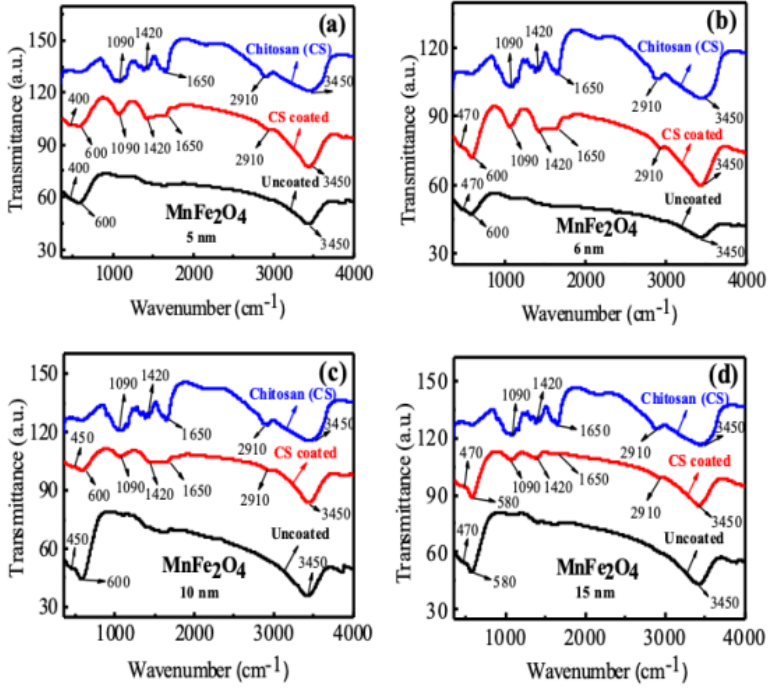
Figure 8. FTIR spectra of uncoated MnFe 2 O 4 , CS-coated MnFe 2 O 4 , and CS nanoparticles for sizes of ( a ) 5 nm, ( b ) 6 nm, ( c ) 10 nm, and ( d ) 15 nm.